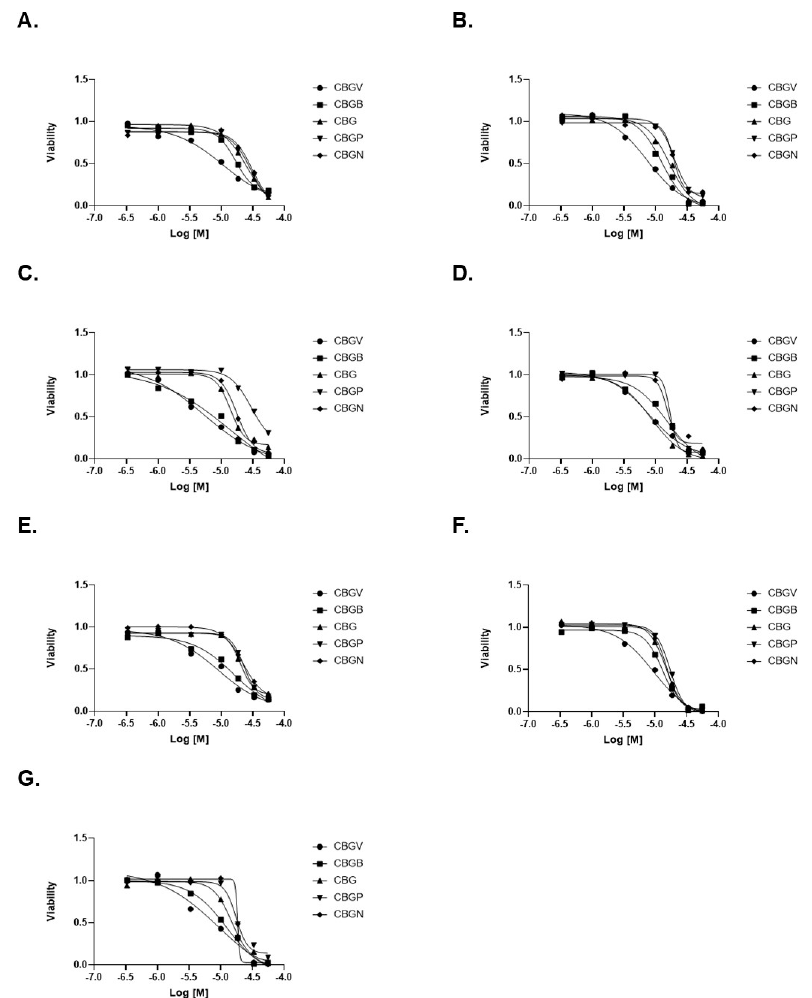
Figure 2. Dose response curves of CBG side-chain variants on colorectal cancer cell viability. Colorectal cancer cell lines were treated with varying doses of cannabinoid for 48 h and then viability was measured using the MTT assay. Representative dose response curves are shown for ( A ) SW480, ( B ) SW620, ( C ) HT29, ( D ) DLD-1, ( E ) HCT116, ( F ) LS174, and ( G ) RKO cell lines. Table 1. IC 50 values for CBG variants in Colorectal Cancer Cell Lines.